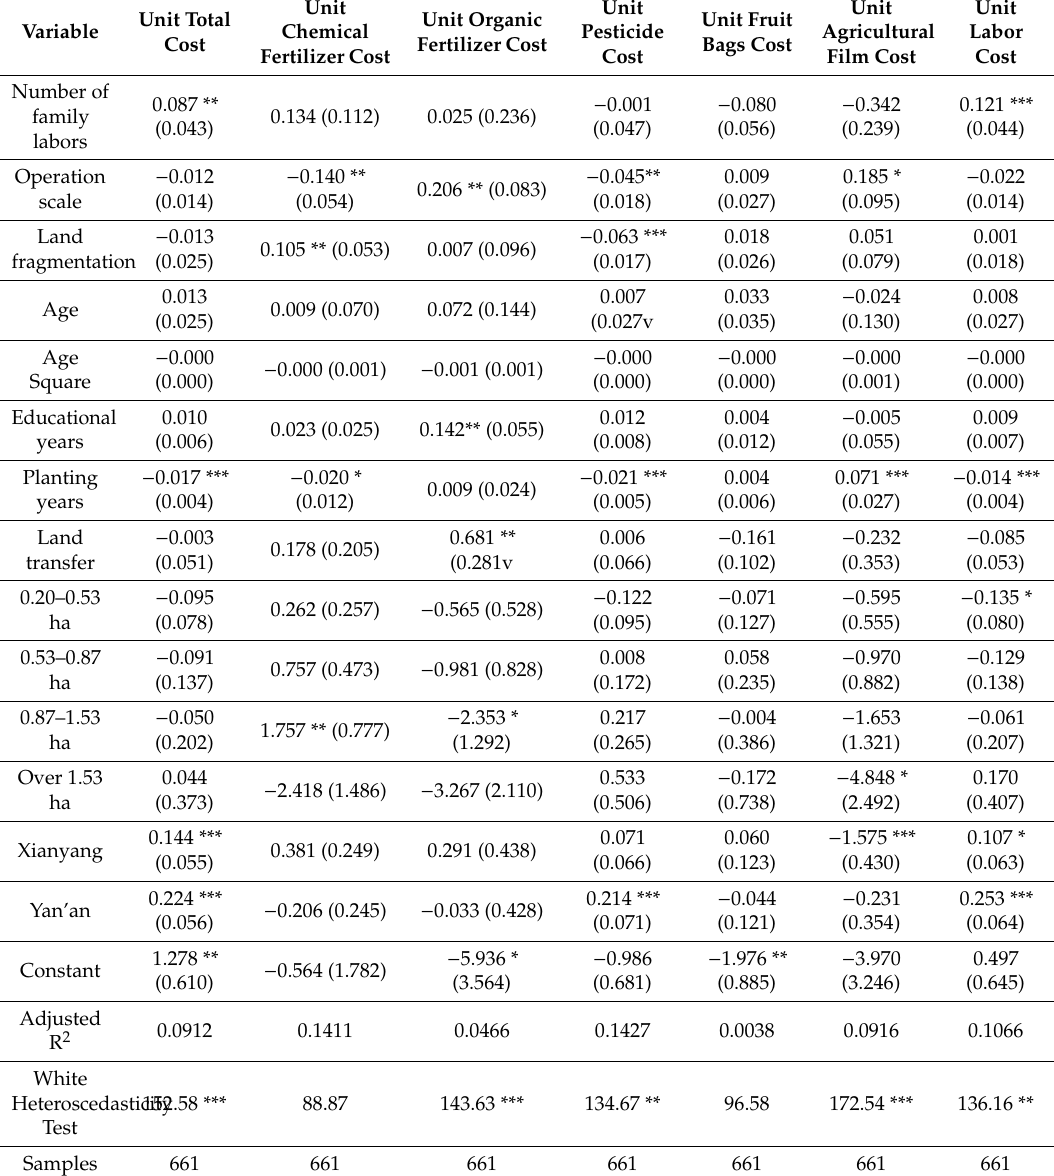
Table 6. Results of the unit production cost